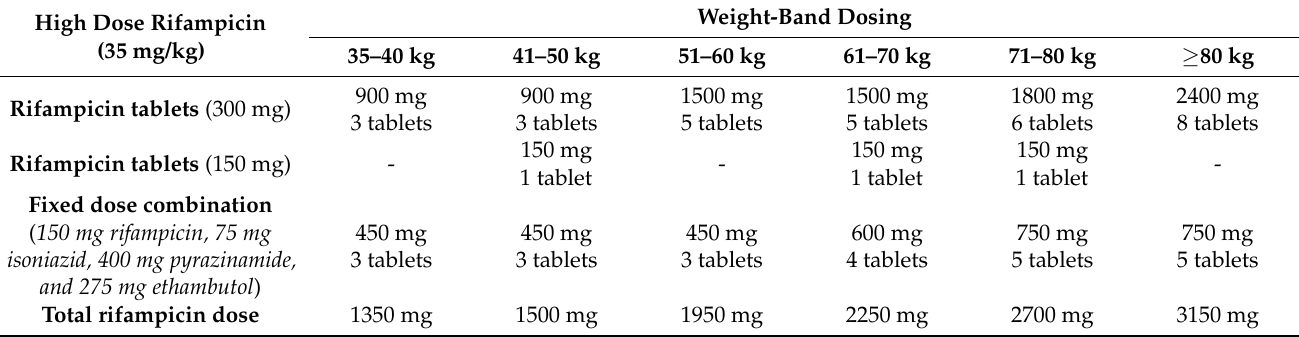
Table 3. Weight-band dosing of